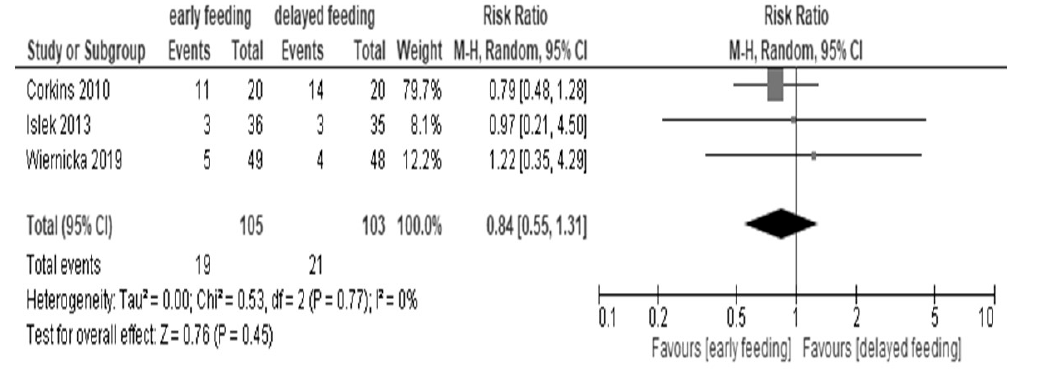
Figure 4. Forest plot of vomiting